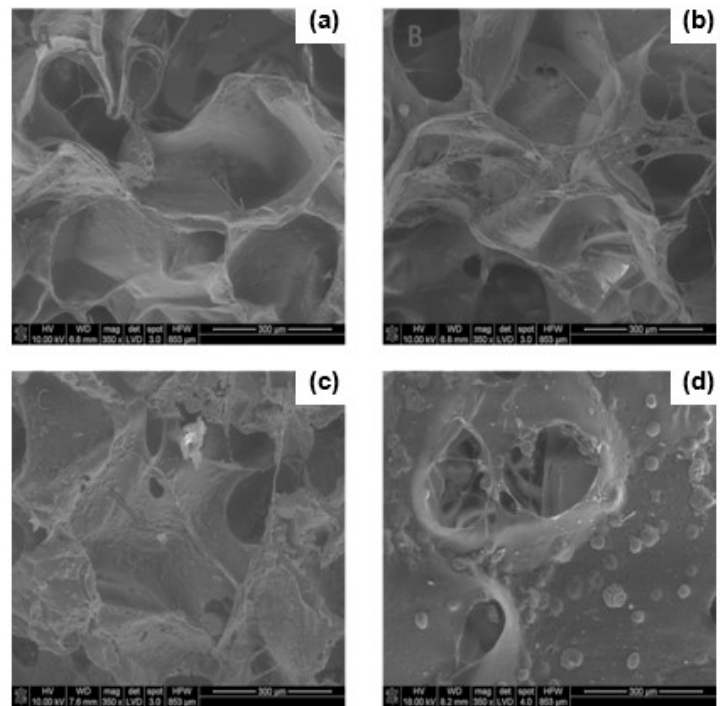
Figure 9. SEM micrographs of fibroblasts NIH 3T3 on the polyurethane ( a , c ), and polyurethane / polylactide 8 / 2 ( b , d ) sponges (350 × ) after 3 days of cell